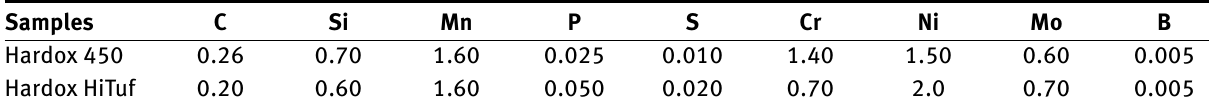
Table 1: The chemical compositions of Hardox 450 and HiTuf steels (wt.%). Samples C Si Mn P S Cr Ni Mo B Hardox 450 0.26 Hardox HiTuf